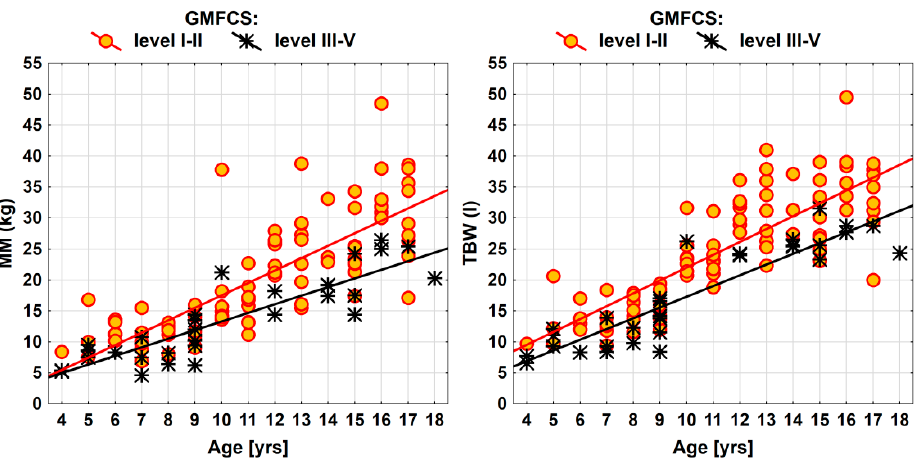
Figure 2. Effects of motor function in muscle mass and total body water in the children with CP. Figure 2. E ff ects of motor function in muscle mass and total body water in the children with